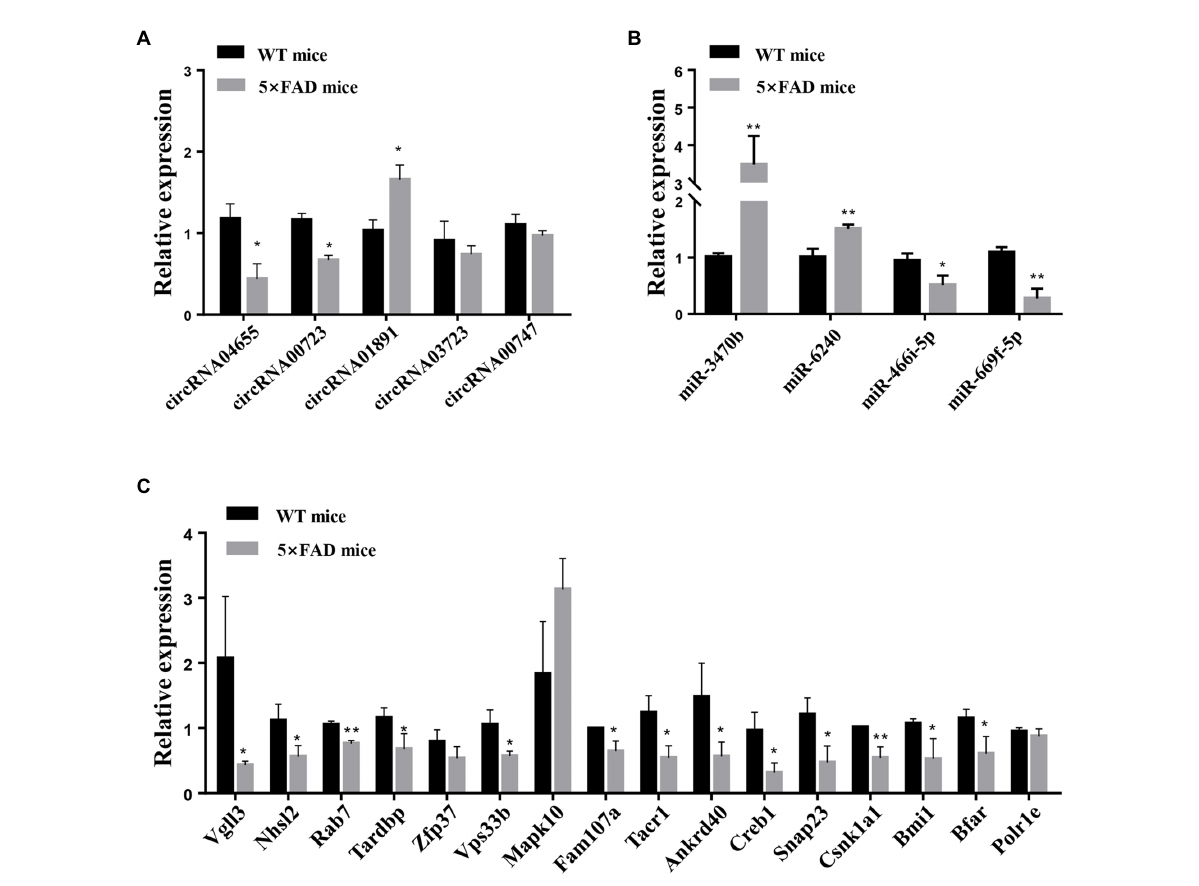
FIGURE 8 qRT-PCR analysis of circRNAs, miRNAs, and mRNAs. (A) Expression levels of circRNAs, including circRNA04655, circRNA00723, circRNA01891, circRNA03723, and circRNA00747, in the hippocampus of 5 × FAD mice and WT mice. (B) Expression of miRNAs, including miR-3470b, miR-6240, miR-466i-5p, and miR-669f-5p, in the hippocampus of 5 × FAD mice and WT mice. (C) Expression of mRNAs, including Vgll3 , Nhsl2 , Rab7 , Tardbp , Zfp37 , Vps33b , Mapk10 , Fam107a , Tacr1 , Ankrd40 , Creb1 , Snap23 , Csnk1a1 , Bmi1 , Bfar , and Polr1e , in the hippocampus of 5 × FAD mice and WT mice. Results are shown as mean ± SD ( n = 3). * p < 0.05, ** p < 0.01 vs. WT